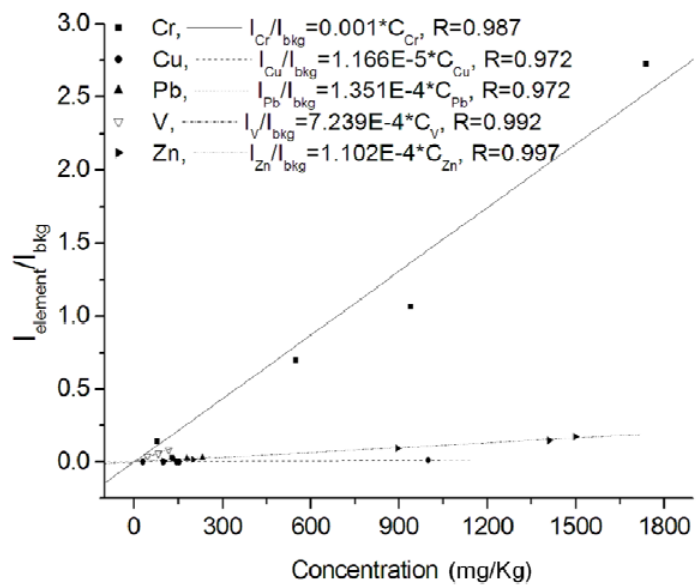
Figure 4. Calibration lines of Cr, Cu, Pb, V, Zn in samples of polluted soils and sewage sludge collected in various Italian